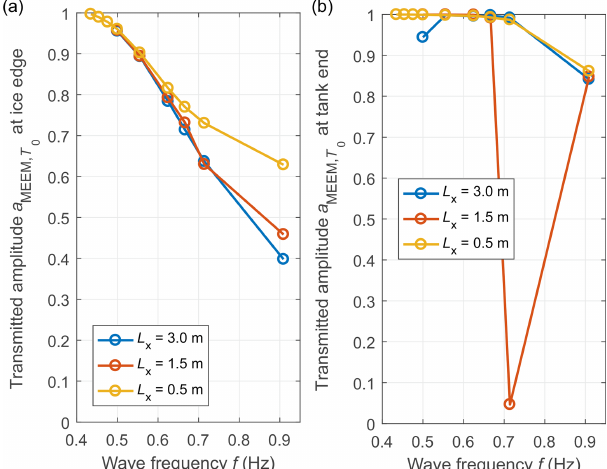
Figure 4. Transmission coefficients computed with the MEEM model for tests from group 3000 (the results for group 2000 are similar): amplitude of the transmitted propagating component at the ice edge (a) and at the end of the tank (i.e. after propagating through the whole ice sheet; b ). All amplitudes are normalized with the re- spective a 0 , w